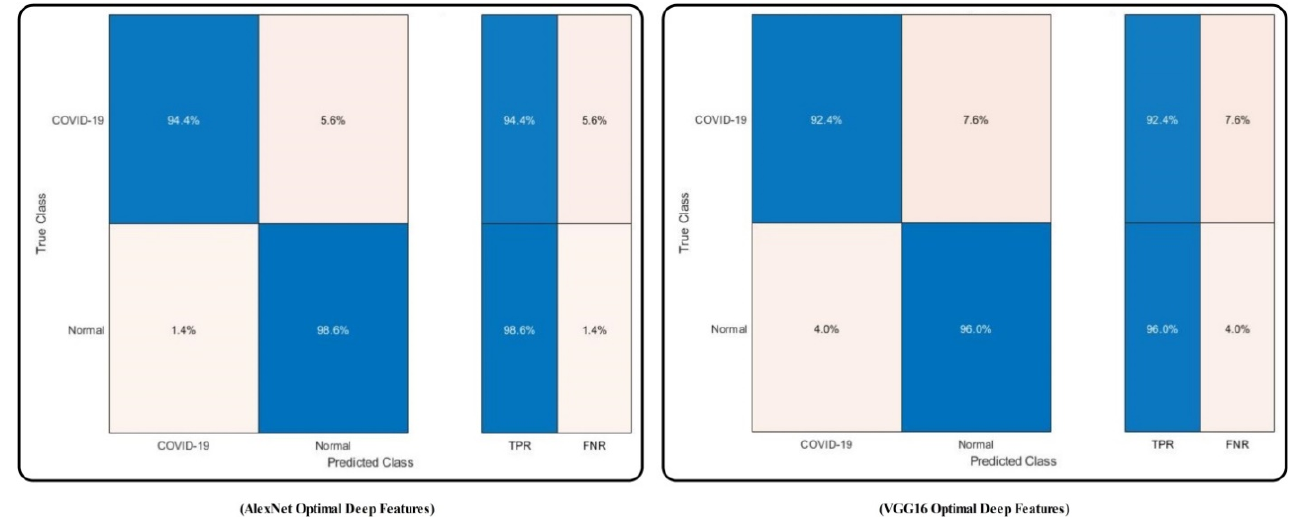
Figure 9. Confusion matrix of MC-SVM for the verification of the achieved accuracy using optimal deep features selection.